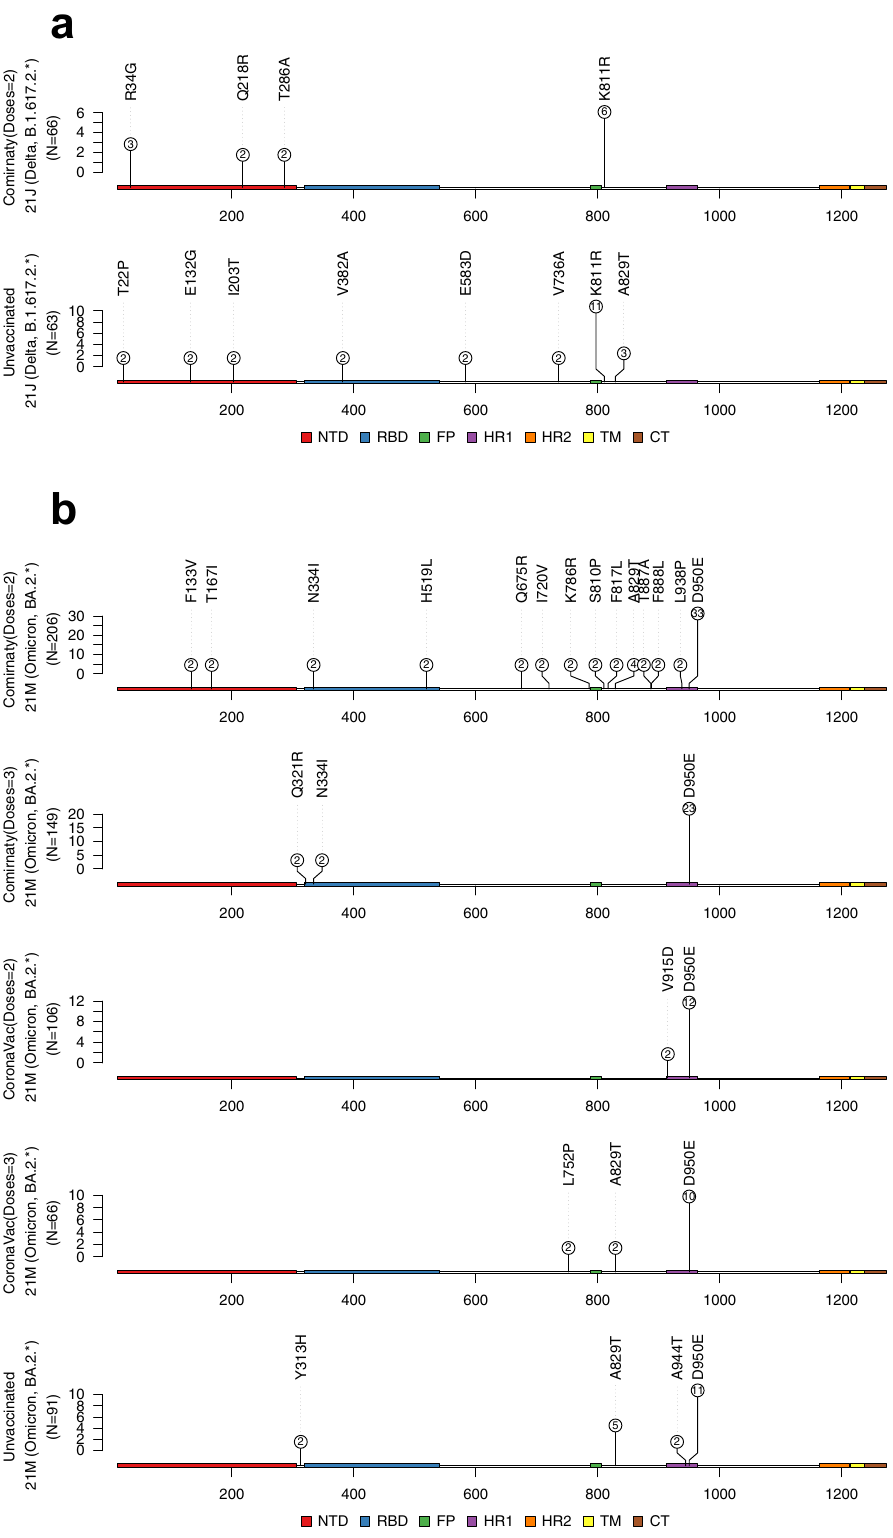
B.1.617.2.*) is not available as no recurrent mutation was found in this group). b Identi fi edwithin-hostmutationsinOmicronsamples.Sourcedataareprovidedas a Source Data fi